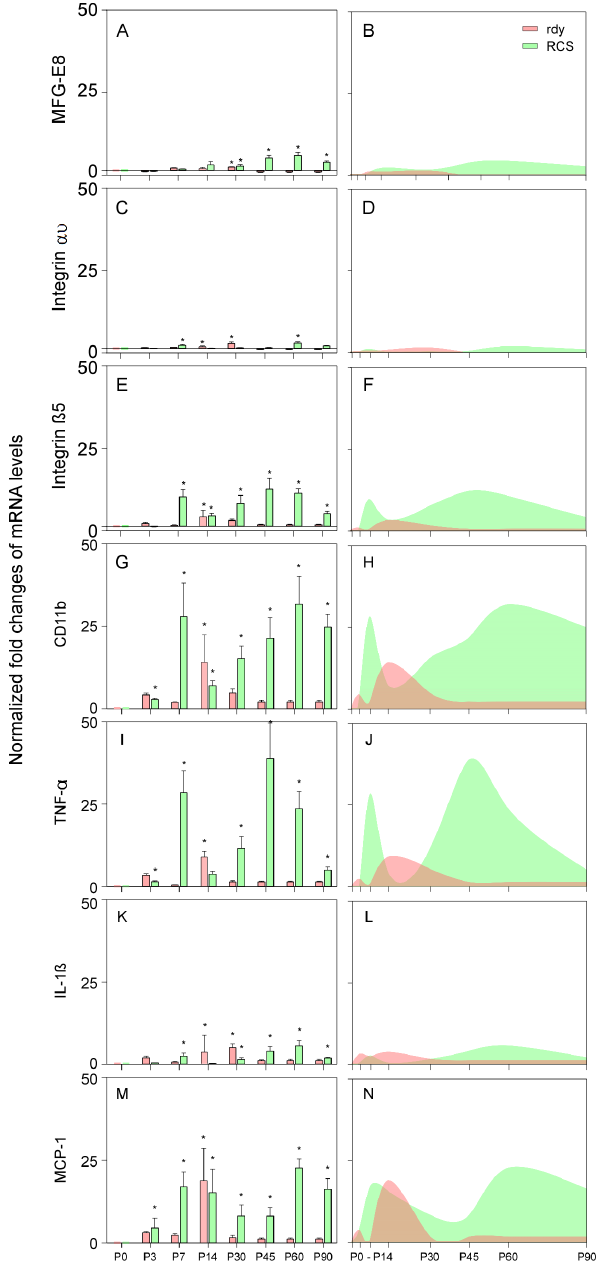
Figure 3. The mRNA expression of MFG-E8 and its integrins ( au and ß5) and inflammatory factors in retinas of RCS and rdy rats. (A–N) all of the gene expression of RCS rats formed a bimodal peak pattern centred at P14 and P45 to P60 but formed a unimodal pattern centred at P14 in rdy rats. The mRNA levels of MFG-E8, integrin au and IL-1 b were relatively lower than the others in both rats, although the expression of integrin b 5, CD11b, TNF- a and MCP-1 were quite high in the two rats, especially in RCS rats (E–J and M–N). *P , 0.05.